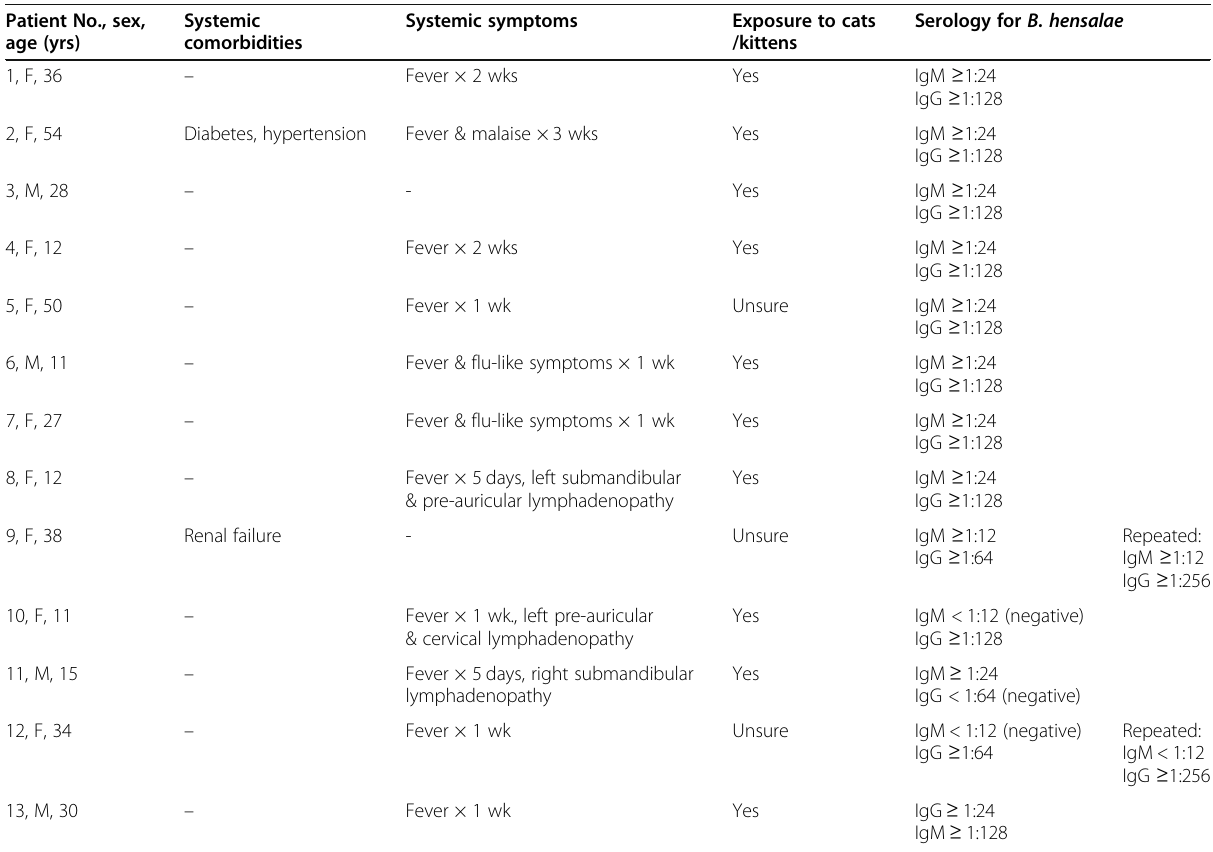
Table 1 Patients ’ demographic data, systemic comorbidities, systemic symptoms, exposure to cats/kittens and serology for B. hensalae Patient No., sex, age